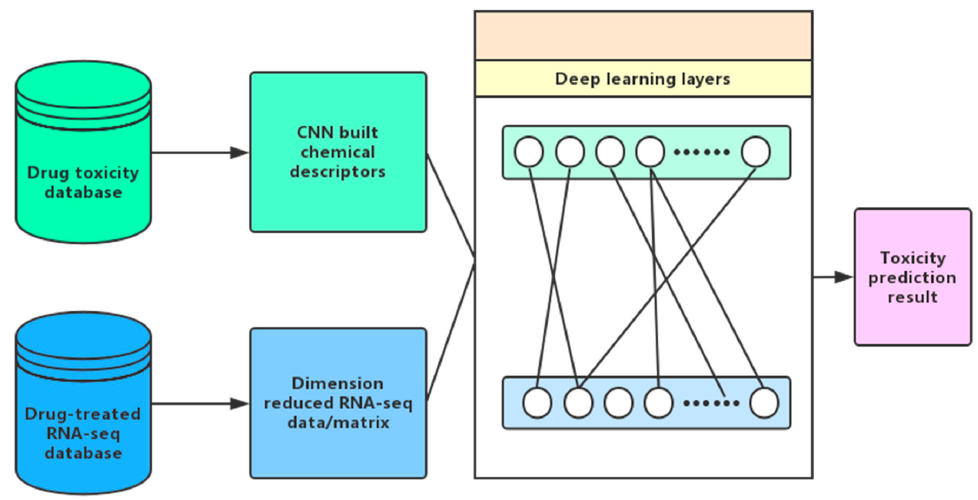
Figure 5. Toxicity prediction with RNA-seq data.